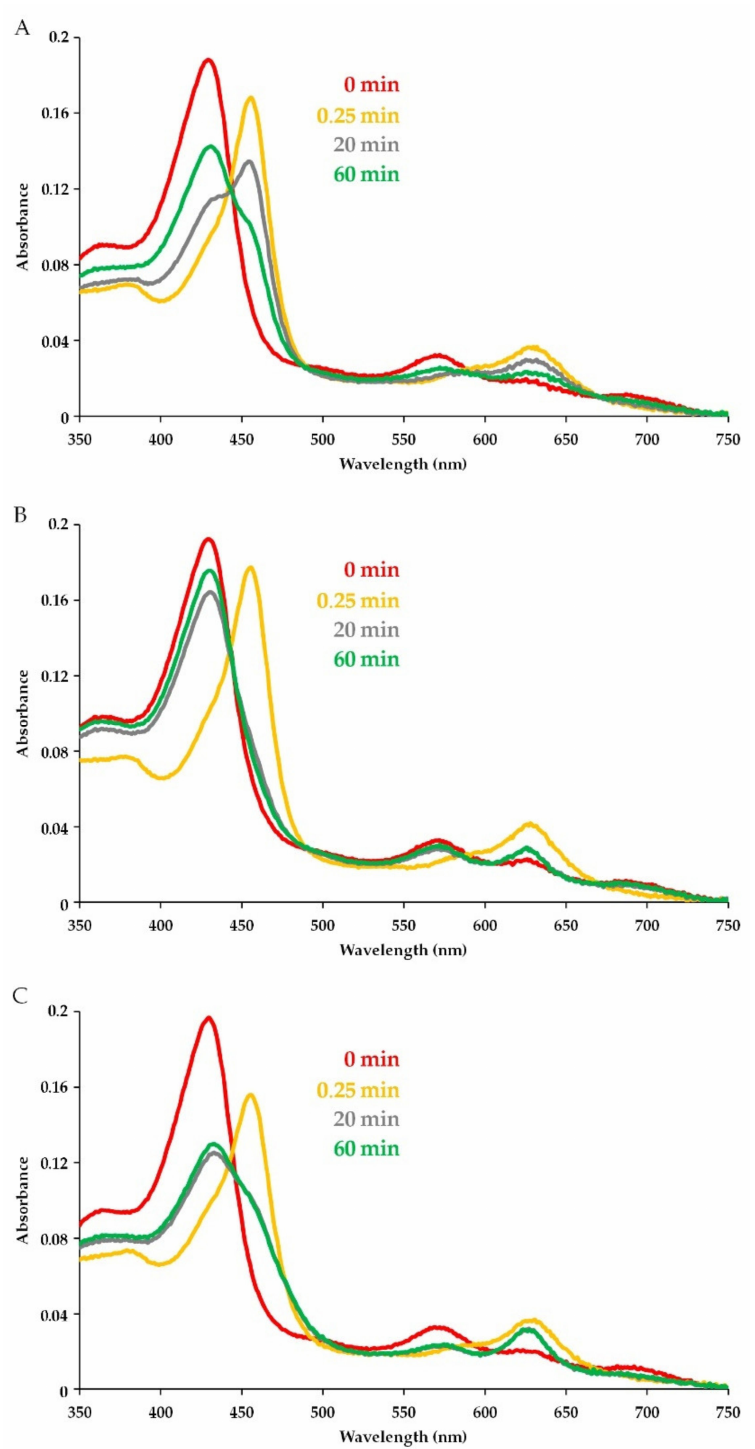
Figure 1. Illustrative absorbance spectra reflecting the reaction of myeloperoxidase (MPO, 2 µ M heme) with H 2 O 2 (100 µ M) in the absence and presence of cationic antimicrobial peptides (CAMPs) in 10 mM Na-phosphate buffer, pH 7.4: ( A ) MPO in the absence of peptides; ( B ) peptide-induced accelerating effect (on the example of pept_1545 at a concentration of 150 µ M); ( C ) peptide-induced inhibitory effect (on the example of Hm-AMP8 at a concentration of 150 µ M). Spectra were taken before (0 min, red color) and 0.25, 20, and 60 min after adding H 2 O 2